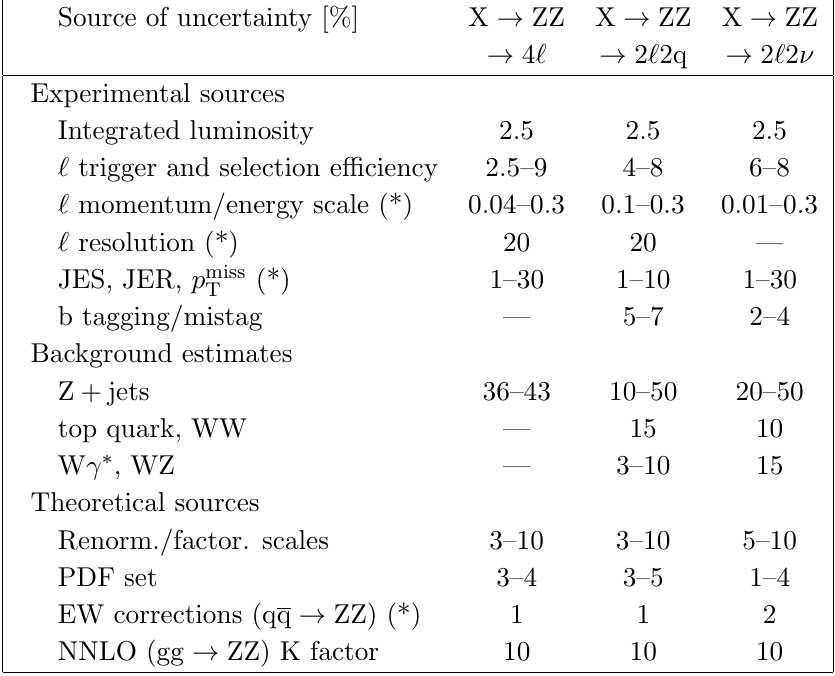
Table 1 . Sources of uncertainties considered in each of the channels included in this analysis. Uncertainties are given in percent. The numbers shown as ranges represent the uncertainties in di(cid:11)erent (cid:12)nal states or categories. Most uncertainties a(cid:11)ect the normalizations of the background estimations or simulated event yields, and those that a(cid:11)ect the shape of kinematic distributions as well are labeled with